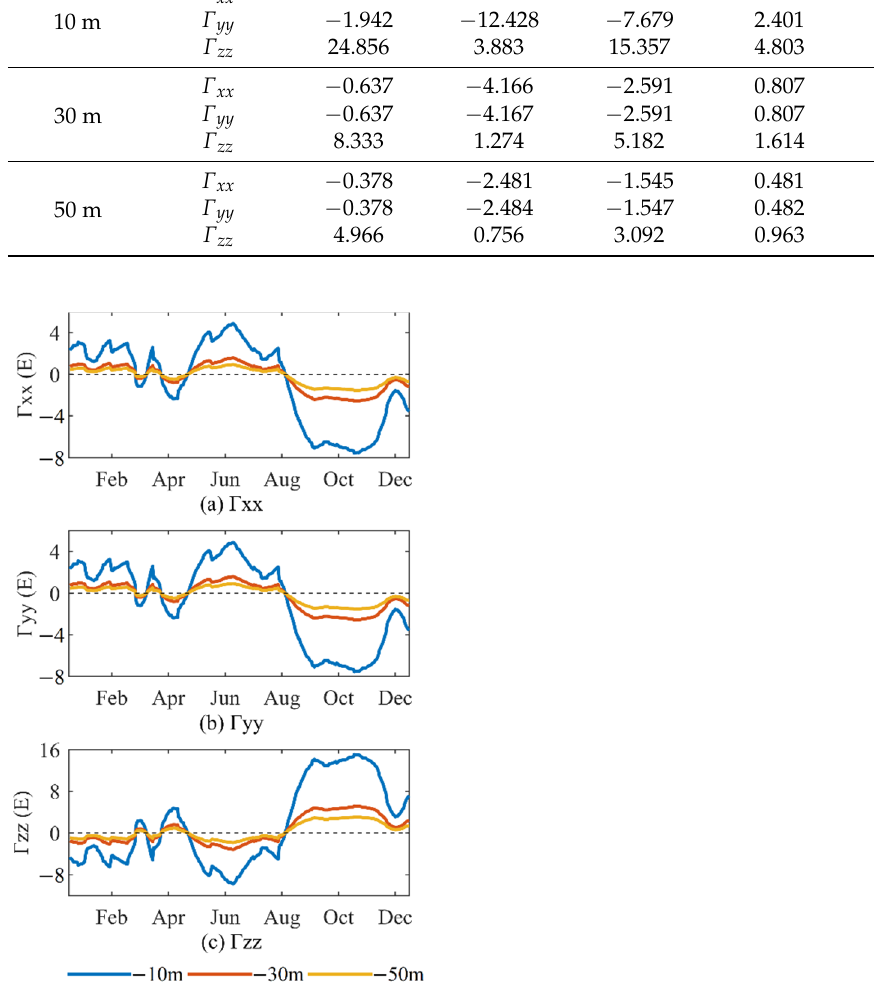
Figure 11. Variation of the disturbing gravity gradient with time at the location of the maximum annual